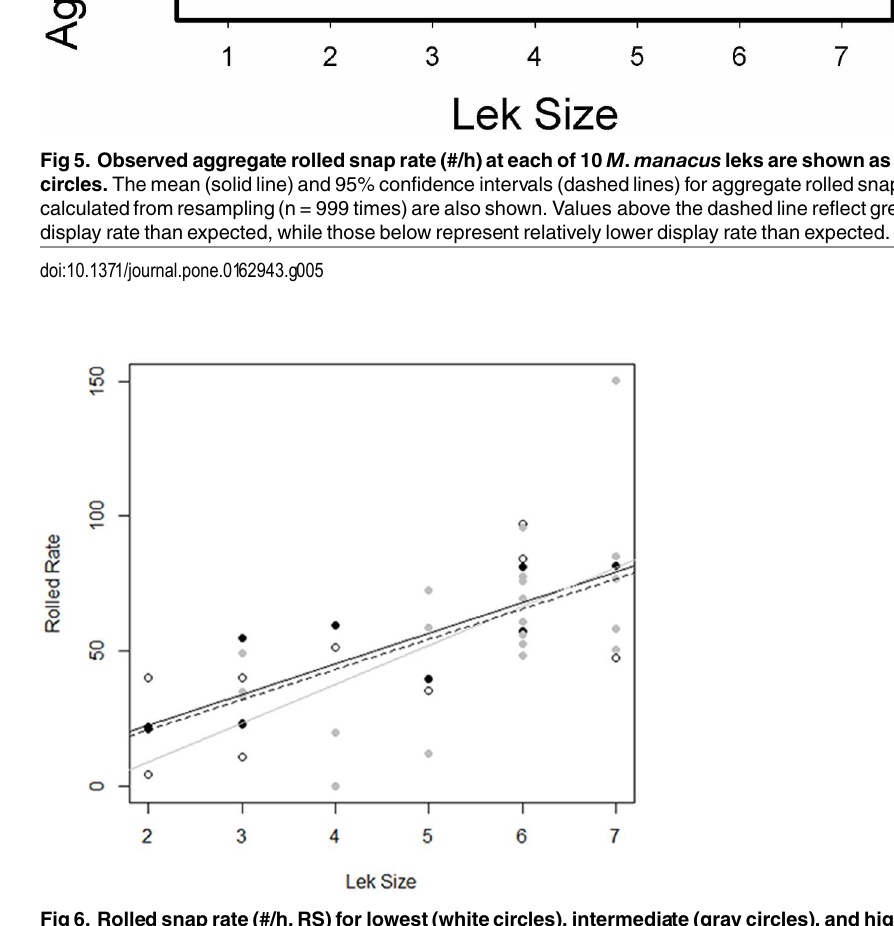
PLOS ONE | DOI:10.1371/journal.pone.0162943 September28,